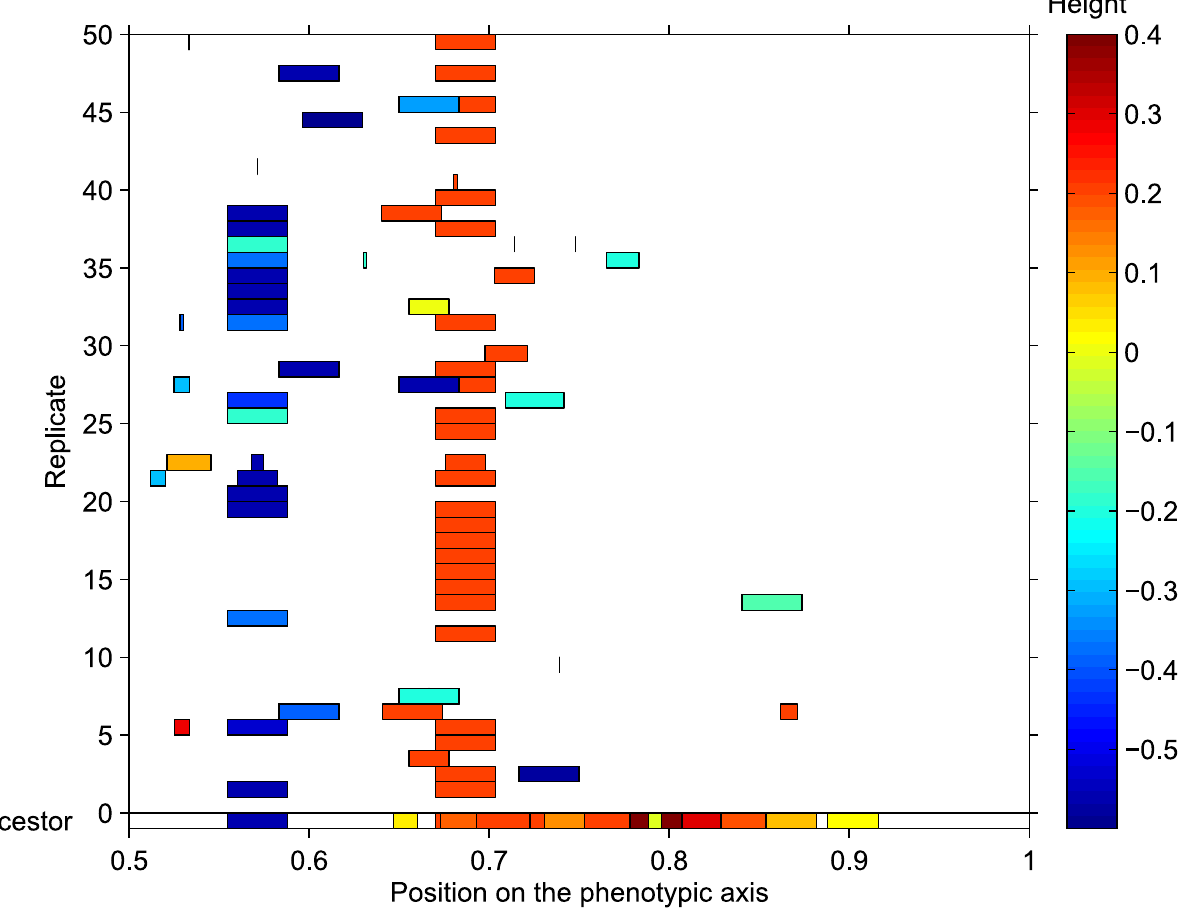
Figure 2. Example of the preferential maintenance of certain secretion genes of a single cooperator from our bank. The bottom row of the graph (ancestor) shows the location on the phenotypic axis of the genes coding for secretion proteins in one cooperator organism from our bank. Above, the secretion genes from the best individual after 1,000 generations of evolution in each of the 50 replicate populations descending from this ancestor are shown. Colors represent the height of the proteins encoded by the genes (see Materials and Methods for detailed explanation of protein properties in Aevol).